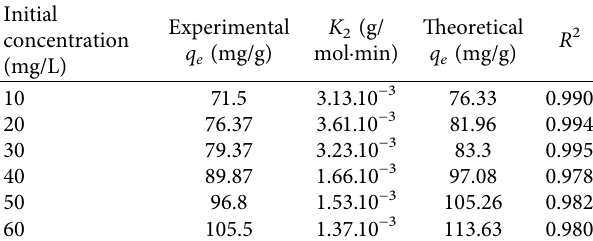
Figure 14: Plot of Ln K